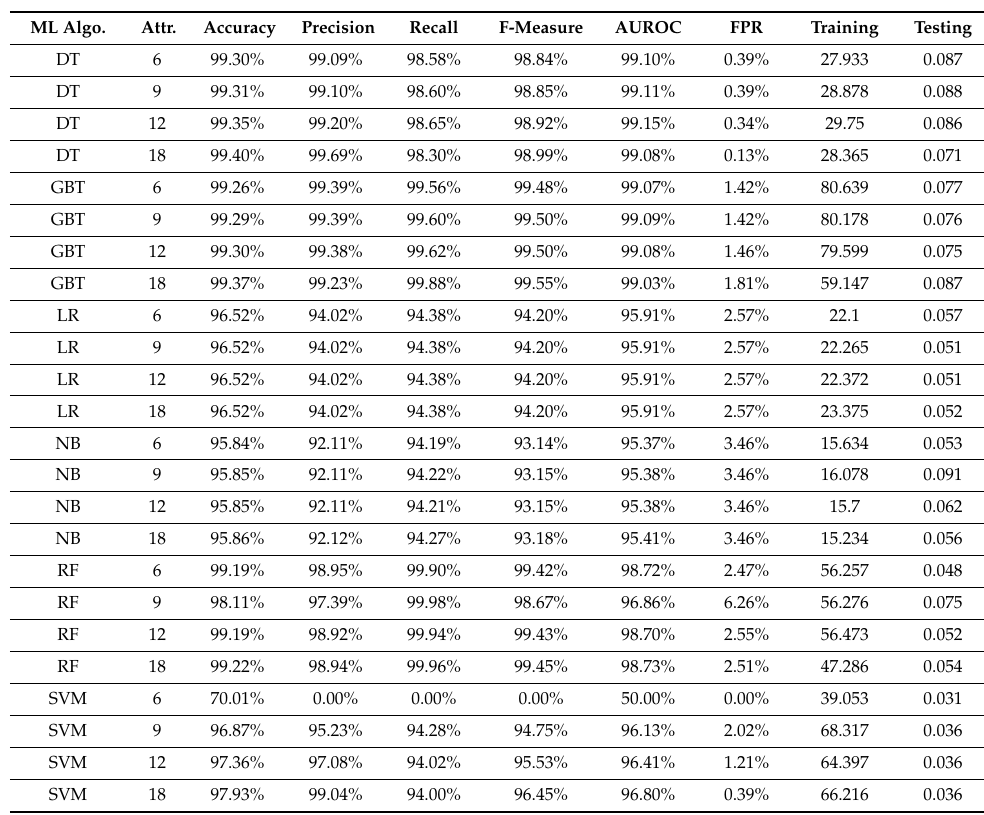
Table 19. Reconnaissance: Performance of the various machine learning classifiers. ML